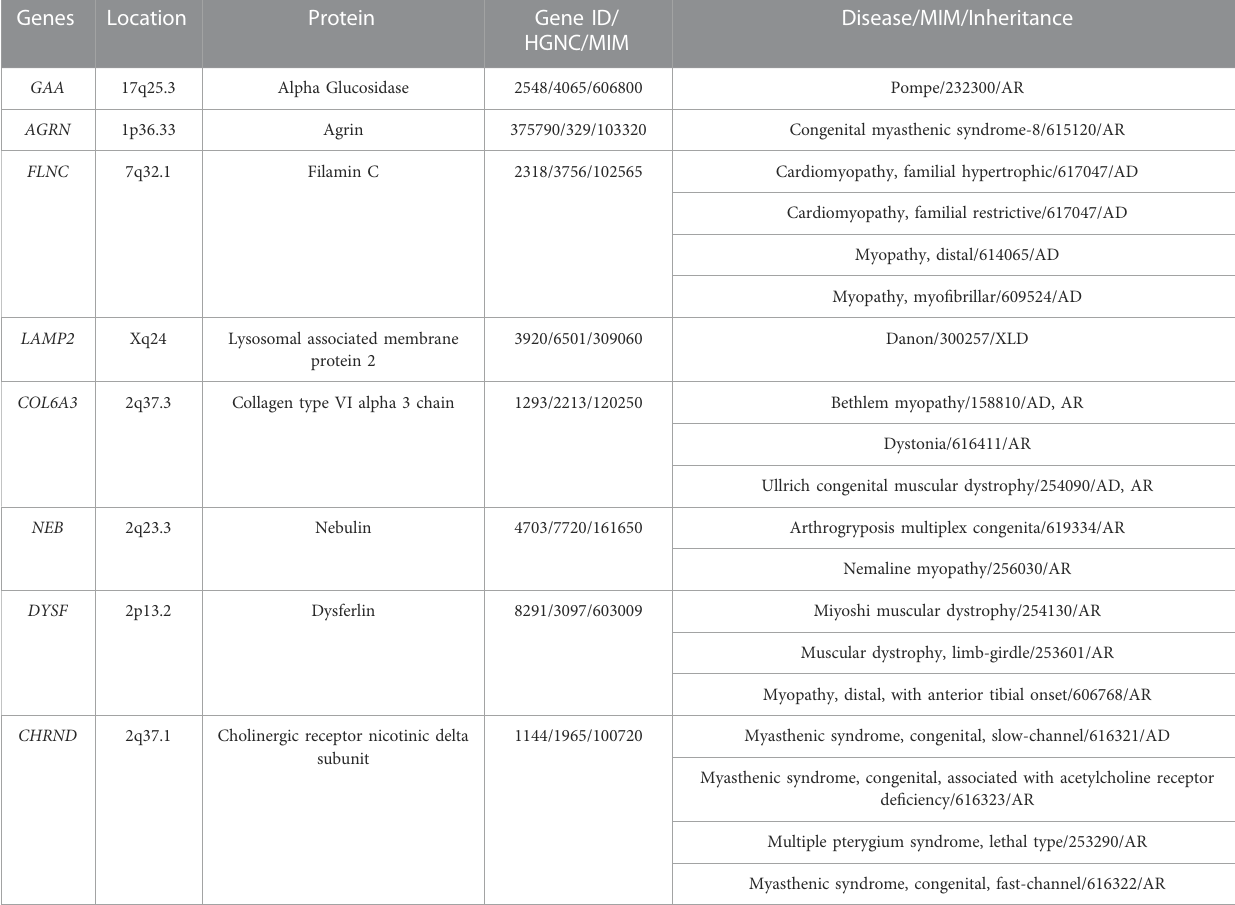
TABLE 2 Additional genes identi fi ed. AD, Autosomic Dominant; AR, Autosomic Recessive; XLD, X-Linked Dominant. Genes